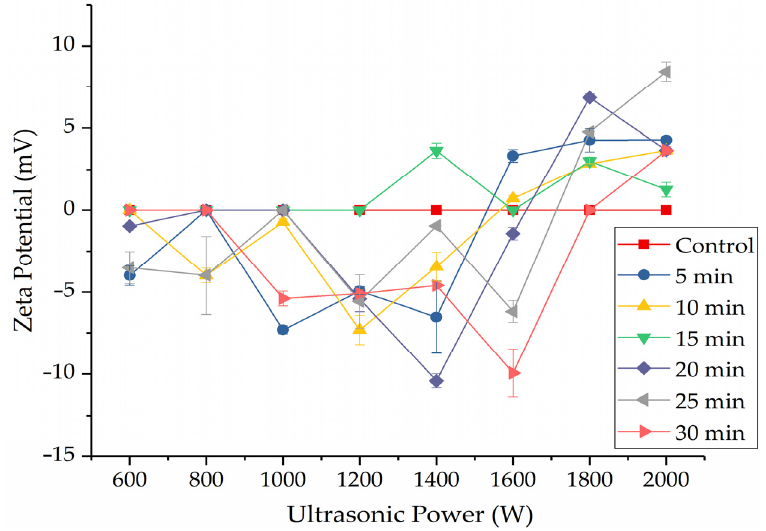
Figure 1. ζ –potential value of HIU–treated WPI. Figure 1. ζ -potential value of HIU–treated